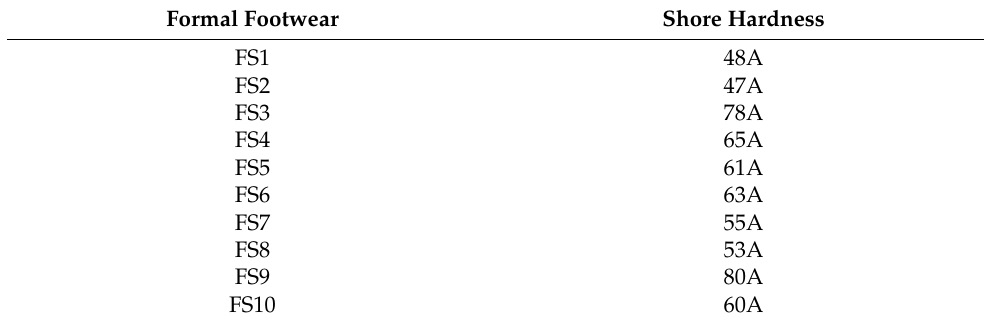
Figure 1. Heel region of the selected Indian formal shoes. Starting from top left (FS1) to bottom right (FS10).